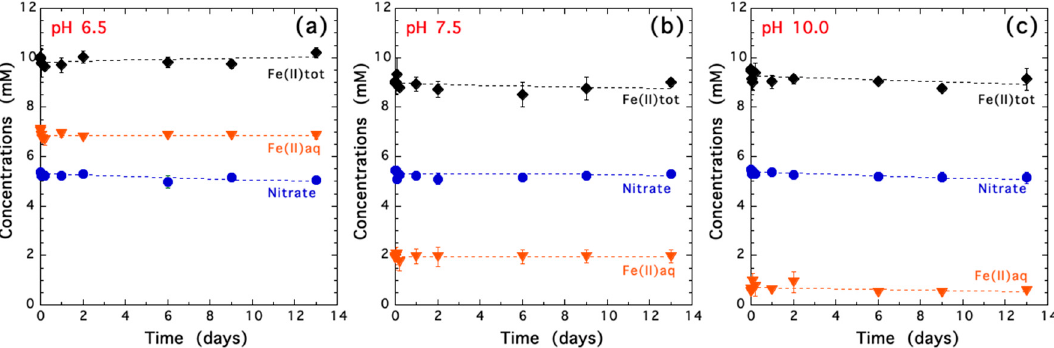
Figure 4. Abiotic nitrate (in blue) interaction with biogenic iron(II-III) hydroxycarbonate green rust at ( a ) pH 6.5; ( b ) pH 7.5 and ( c ) pH 10.0. Fe(II)tot (in black) corresponds to the total Fe(II) concentration measured by the 1,10-phenanthroline colorimetric analysis after 0.5 M HCl extraction. Fe(II)aq (in orange) corresponds to the dissolved Fe(II) concentration measured by the 1,10-phenanthroline colorimetric analysis in samples filtered through the 0.22 µm pore size filters. Experimental data were fit using a linear regression fitting procedure (dashed lines).